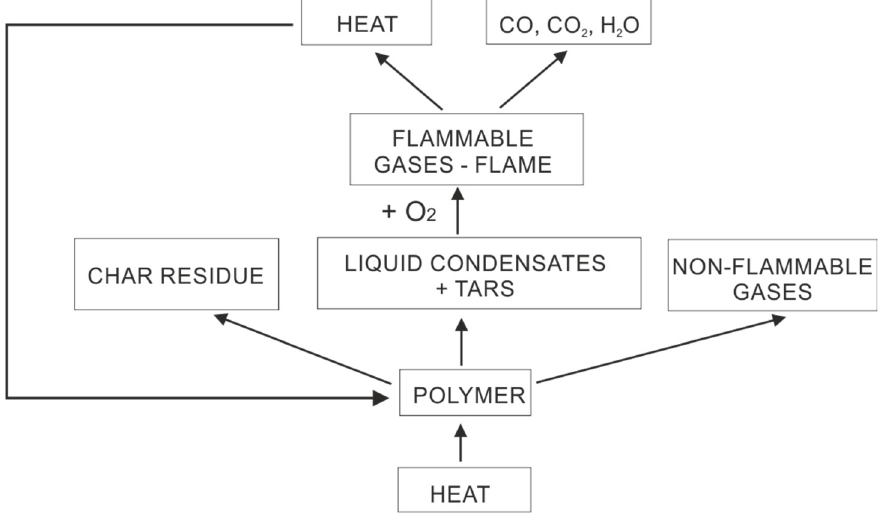
Figure 1. Schematic of polymer burning [5] Reproduced with permission from Magovac, E.; Bischof, S., Tekstil; published by Hrvatski inzenjerski savez tekstilaca, 2015. To prevent or to stop the fire, one or more contributors of the fire have to be removed.